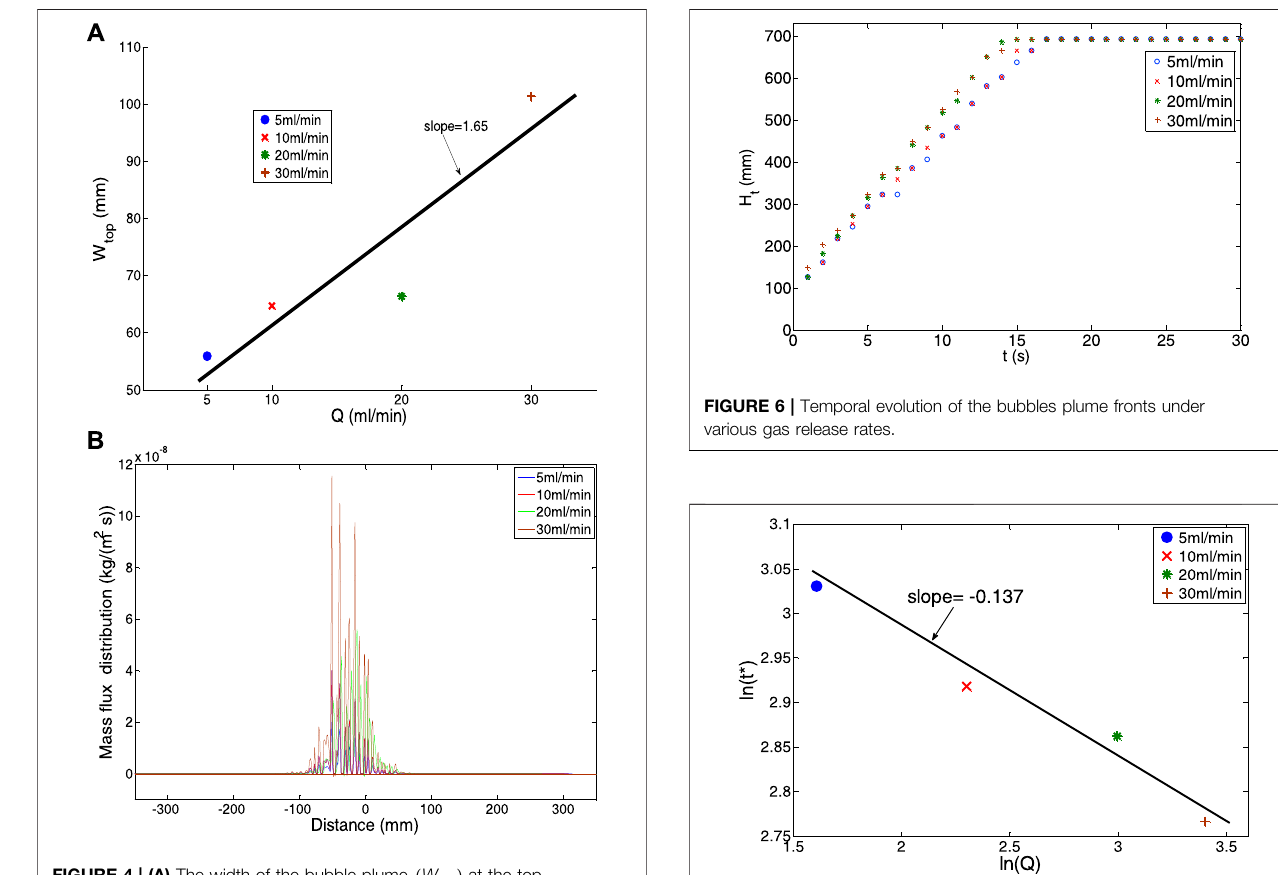
FIGURE 4 | (A) The width of the bubble plume ( W top ) at the top boundaryofthedomain; (B) thegasmass fl uxdistributionatthetopboundary of the domain.